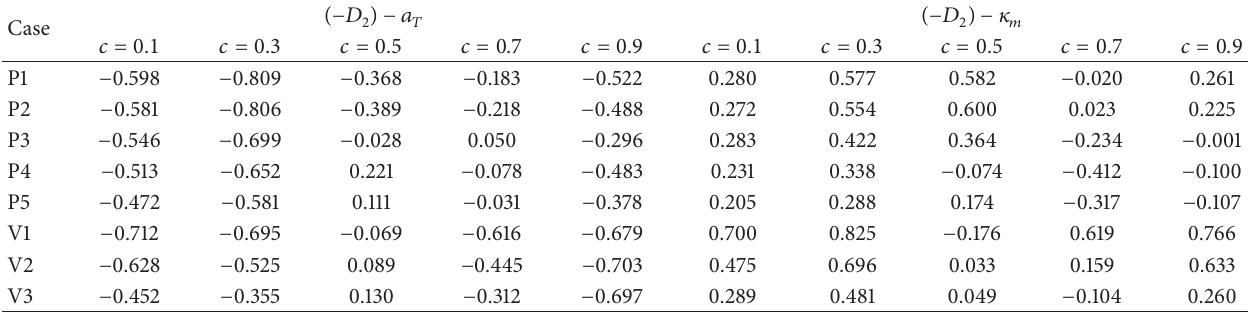
Table 3: Correlation coefficients between (−𝐷 2 ) and 𝑎 𝑇 and between (−𝐷 2 ) and 𝜅 𝑚 on 𝑐 = 0.1 , 0.3, 0.5, 0.7, and 0.9